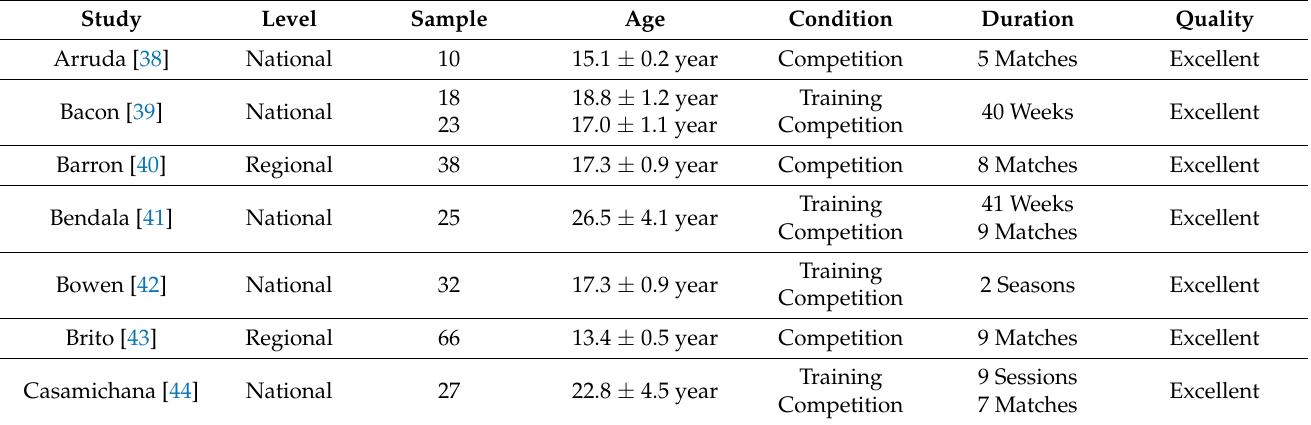
Table 2. Characteristics of studies that evaluated only external load